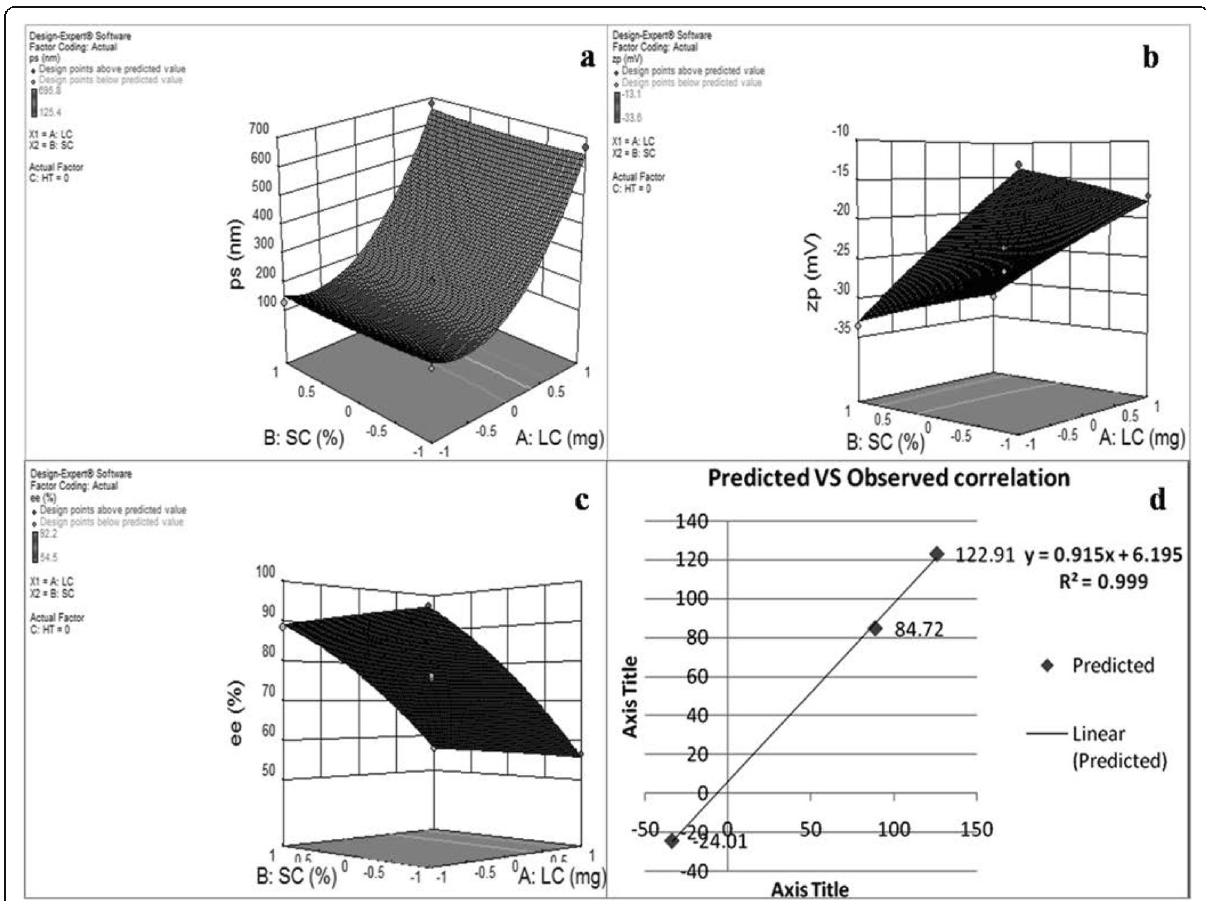
Fig. 4 Effect of independent variables like lipid concentration, surfactant concentration on dependent variable like a particle size, b zeta potential, c entrapment efficiency, and d predicted vs. observed value